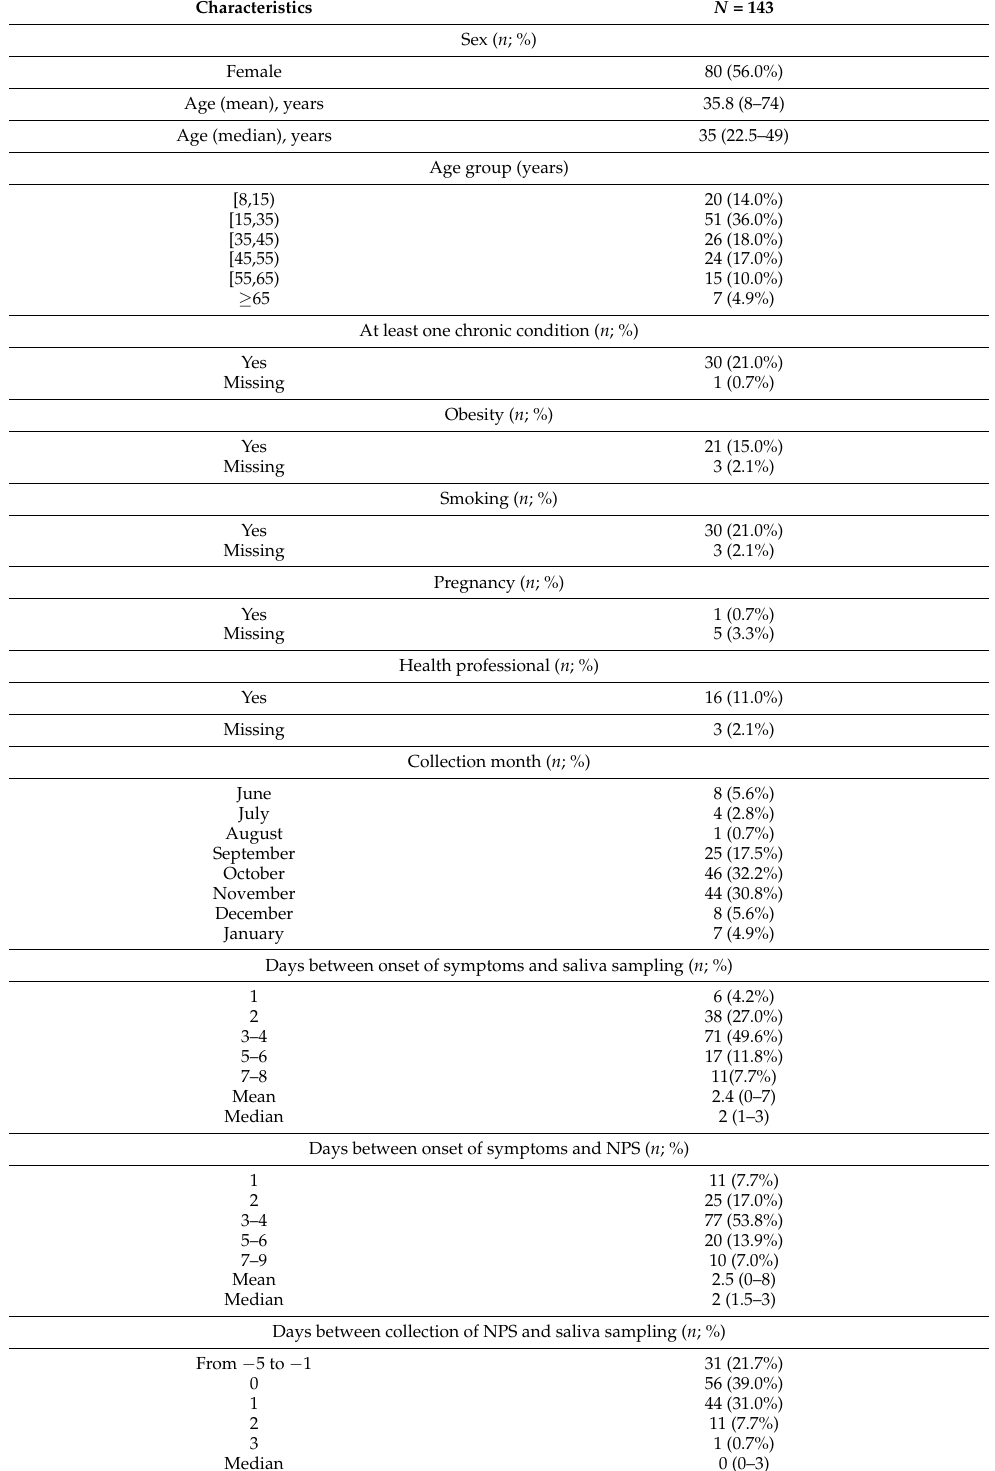
Table 1. Characteristics of patients with ARI included by the Sentinelles